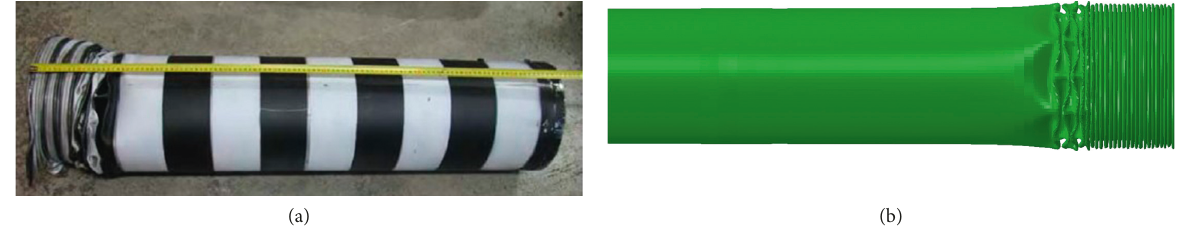
Figure 8: Deformation of the missile. (a) Experiment. (b) Numerical